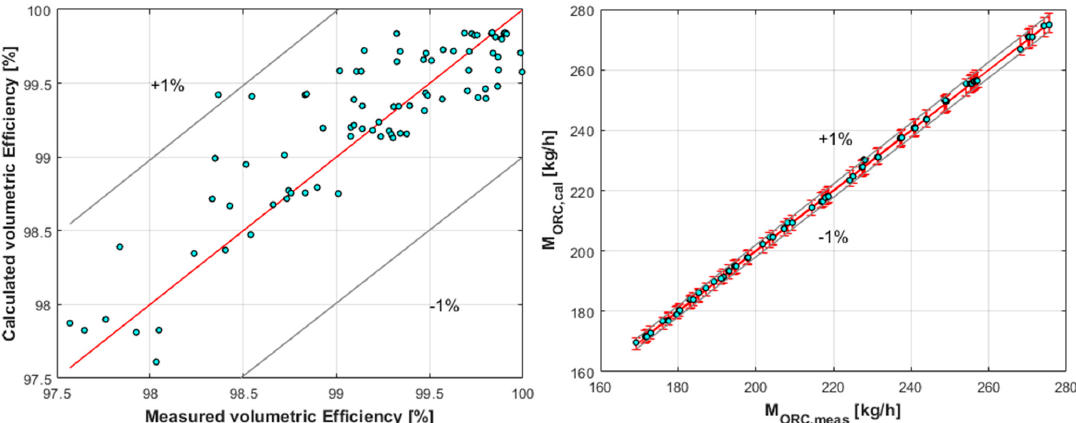
Figure 13. Measured and calculated pump volumetric efficiency ( left ) and pump mass flow rate ( right ).